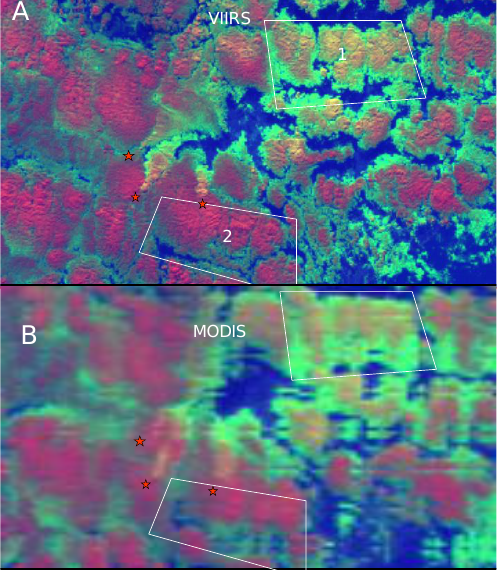
Fig. 6. Same as Fig. 1, but showing the three pollution point sources over the three coal power plants in the La Trobe Val- ley, Australia, as seen by VIIRS (04:07UT, panel A ) and MODIS (04:40UT, panel B ) overpasses on 29 April 2012, in an area of 170km × 116km centered at 38.04 ◦ S, 146.69 ◦ E. The red stars are positioned below the pollution point sources, which their aerial pho- tos are shown in Fig. 7. The pollution tracks spread northward with the southerly low-level wind and merge to the northeast and form a homogeneously polluted region that includes rectangle 1. The pol- luted clouds spread eastward with the westerly wind at the clouds altitude. The background clouds to the south include rectangle